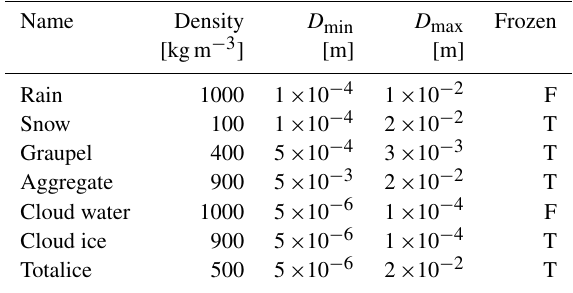
Table 2. Placeholder hydrometeor types.